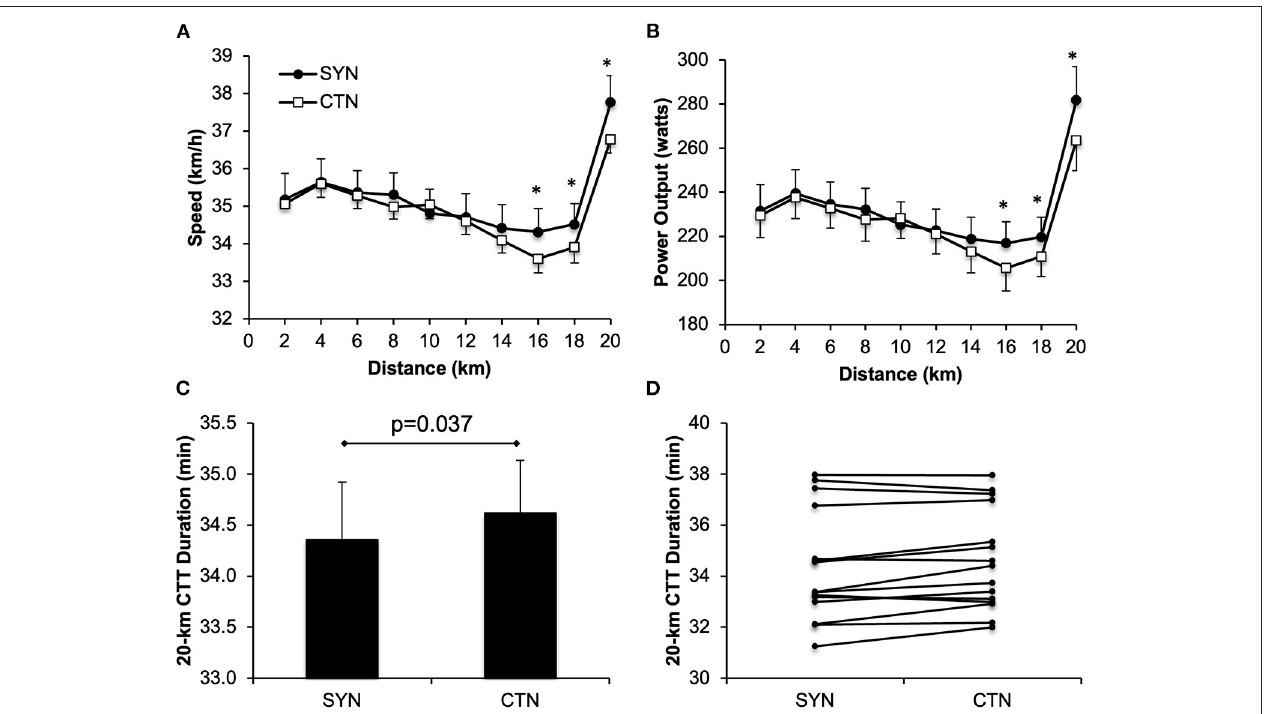
FIGURE 2 | Effect of wearing athletic clothing made of synthetic fabrics (SYN, 60% polyester:40% nylon) and 100% cotton fabric (CTN) on 20-km cycling time trial (CTT) performance parameters in endurance-trained adults ( n = 15). Values in panels (A–C) are means ± SE. Data points in panel (D) are individual participant values under SYN and CTN conditions. * p < 0.05 vs.